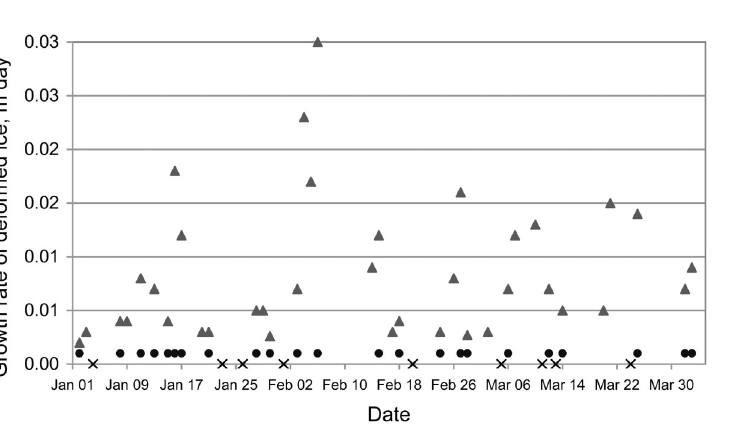
Fig. 10. Time series of the deformed ice growth rate (triangles) and the events of ship damage. Ship damages that occurred during high deformation or in calm ice conditions are marked with circles and crosses,